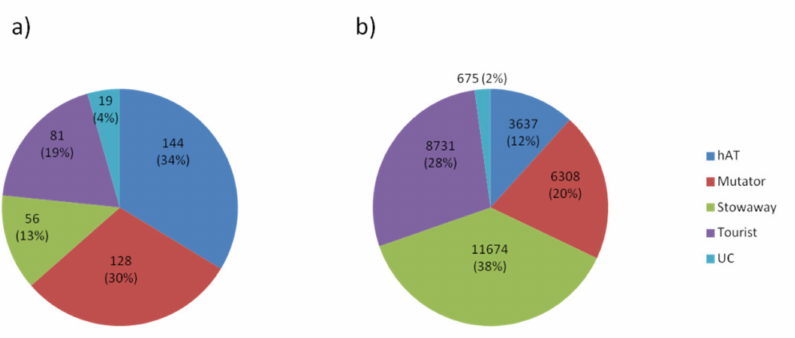
Figure 1. Abundance of MITE groups in the carrot genome with respect to the number of families ( a ) and the number of copies ( b ). UC stands for unclassified